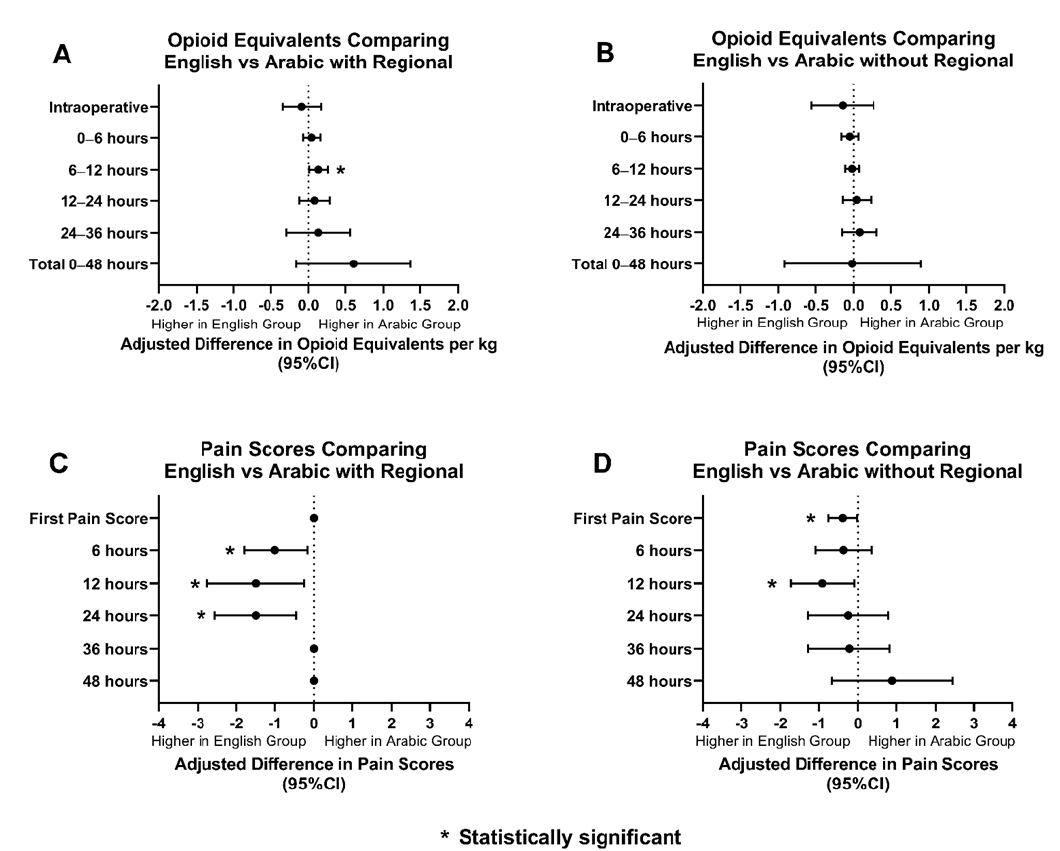
Figure 3. Opioid equivalents and pain score comparisons amongst ES and AS patients with and without regional anesthesia. ( A ): Adjusted difference in opioid equivalents per kg vs. time in English vs. Arabic patients with regional anesthesia; ( B ): Adjusted difference in opioid equivalents per kg vs. time in English vs. Arabic patients without regional anesthesia; ( C ): Adjusted difference in pain score vs. time in English vs. Arabic patients with regional anesthesia; ( D ): Adjusted difference pain score vs. time in English vs. Arabic patients without regional anesthesia. Table 4. Multivariable Median Regression Analysis of Outcomes Compared by Language